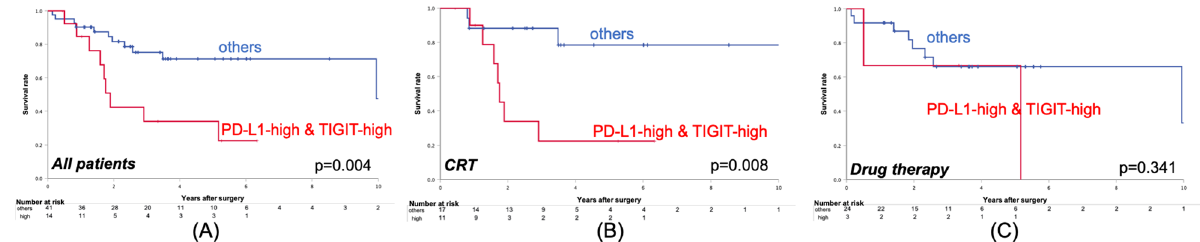
Figure 5. Overall survival curves regarding the expression of PD-L1 together with TIGIT. The results are shown according to ( A ) all patients, ( B ) patients treated with cCRT, and ( C ) those treated with drug